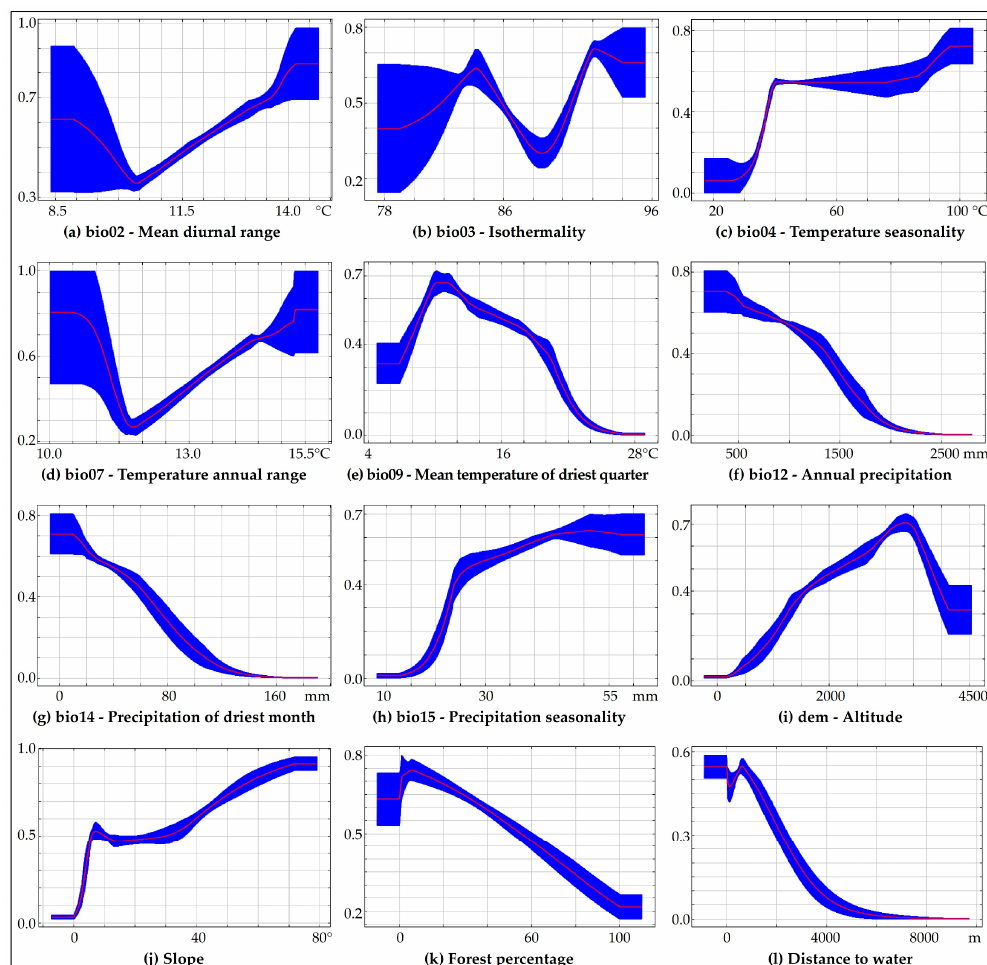
Figure 2. Mean response curves of the 10 replicated MaxEnt runs (red) and standard deviation (blue), showing the relationships between environmental variables and the probability of presence of the spectacled bear. If the °C of temperature ( a – e ), mm of precipitation ( f – h ), m a.s.l. ( i ), degrees of slope ( j ), percentage of forest ( k ) or distance to water ( l ) increase ( x -axis), the probability of presence of the spectacled bear increases or decreases from 0 to 1 ( y -axis).